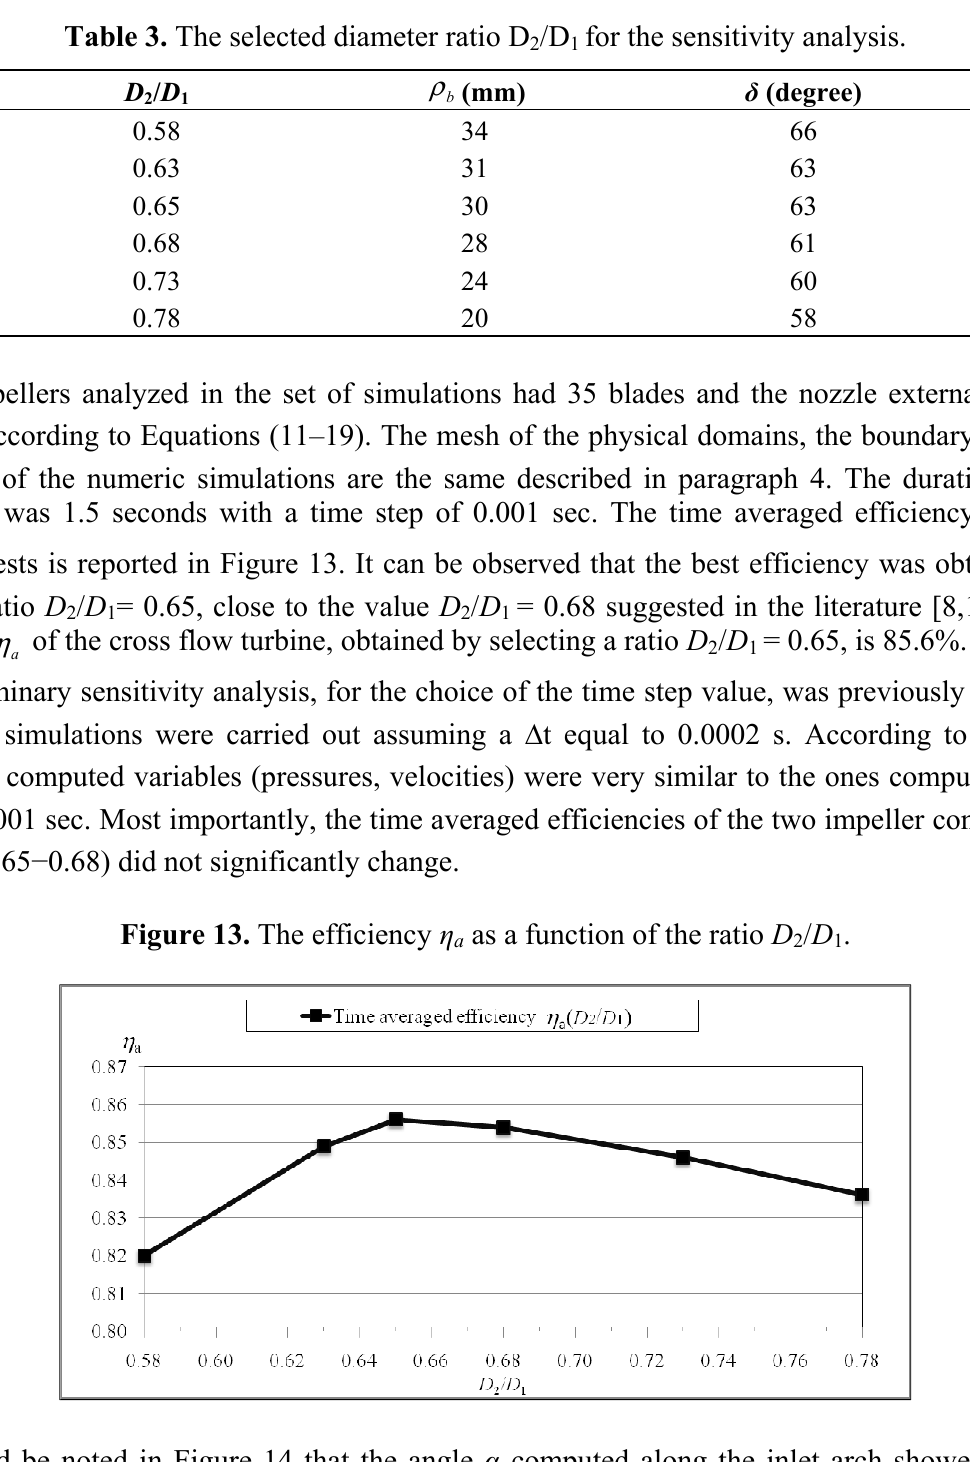
Table 3. The selected diameter ratio D